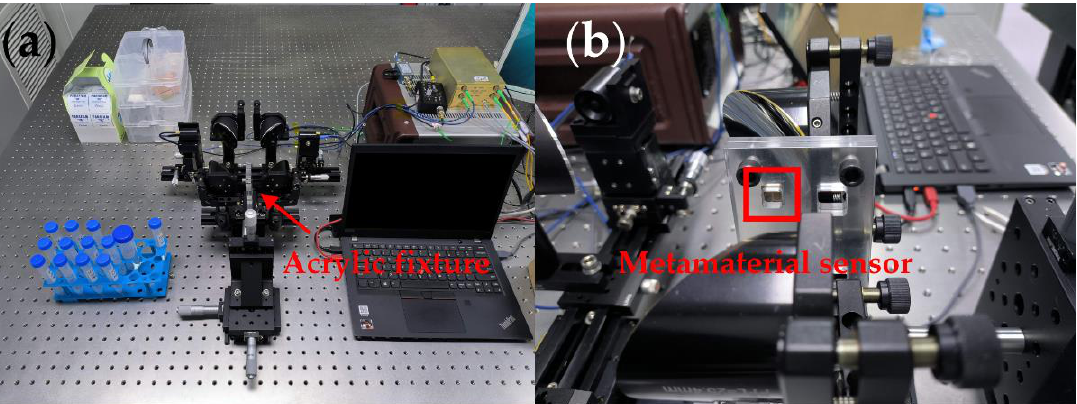
Figure 7. Spectral measurement images: ( a ) THz-FDS in sample measurement; ( b ) Sample fixing device.